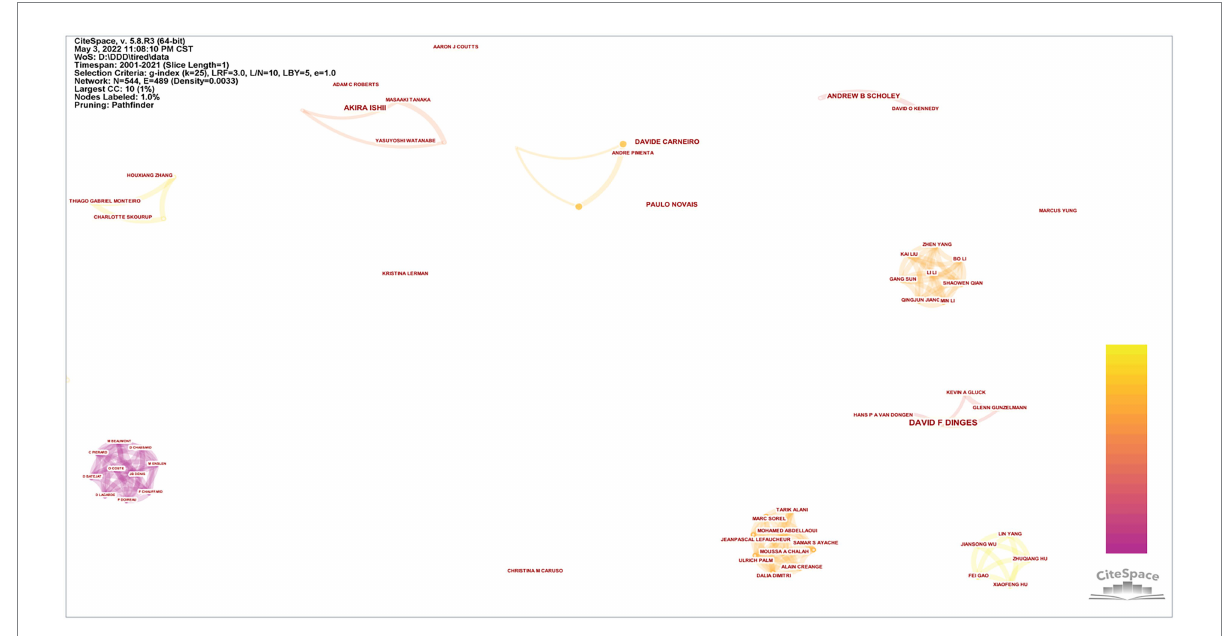
FIGURE 6 The cooperation network visualization map of authors based on CiteSpace.